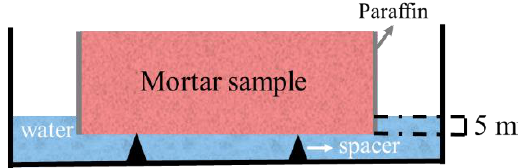
Figure 3. Illustration of the water absorption test.